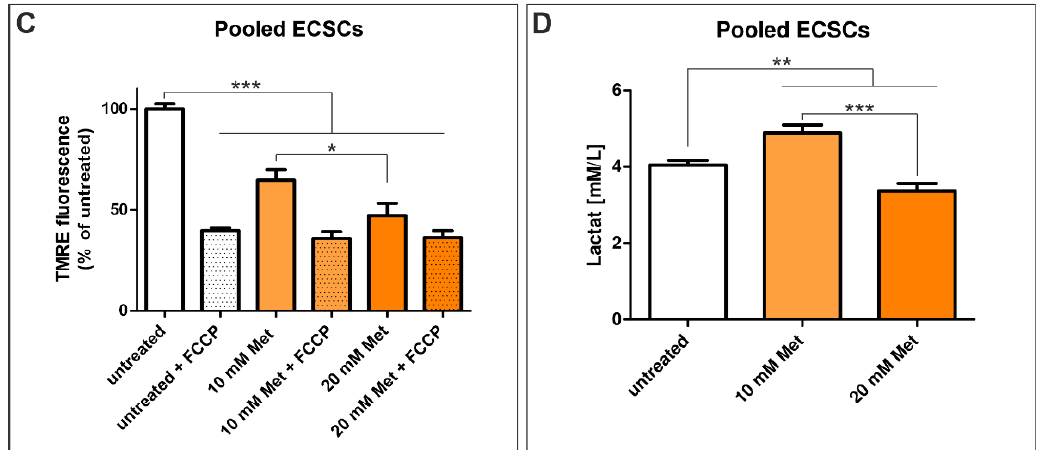
Figure 7. Treatment with metformin and carboplatin significantly decreases the survival of endometrial carcinoma-derived stem-like cell populations. To analyze the influence of carboplatin and metformin, the cells were treated with different concentrations of the reagents for 72 h. Afterwards, cellular viability was measured using Orangu TM (Cell Guidance Systems, Cambridge, U.K., Cambridge, U.K.) and the cell count was determined by using the respective standard curve. ( A ) Statistical analysis of the survival rates of the pooled ECSCs revealed a significantly decreased survival of ECSCs for every tested concentration of carboplatin and metformin in a dose-dependent manner. ( B ) Analysis of the half maximal inhibitory concentration (IC 50 ) for carboplatin revealed an IC 50 value of 46.79 µM for BKZ-10, 49.24 µM for BKZ-11 and 16.41 µM for BKZ-12. The IC 50 value for metformin was assessed as 6.787 mM for BKZ-10, 5.996 mM for BKZ-11 and 6.002 mM for BKZ-12. ( C ) Membrane potential of ECSCs was measured using TMRE, and the mitochondrial oxidative phosphorylation uncoupler FCCP was used as a technical control. Treatment with 10 and 20 mM metformin significantly reduces the membrane potential of ECSCs in comparison to untreated cells. ( D ) The lactate concentration of the media of untreated and treated cells was determined using Accutrend ® Plus, which revealed a significantly enhanced lactate concentration after treatment with 10 mM metformin and a significantly decreased concentration after treatment with 20 mM metformin. Means ± SEM (standard error of the mean) were statistically analyzed by an unpaired t -test ( n = 3, * p ≤ 0.05, ** p ≤ 0.01, *** p ≤